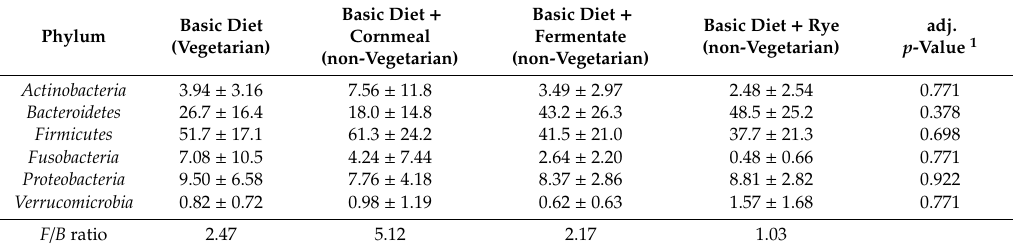
Figure 4. Box-and-whisker plot illustrating the Firmicutes / Bacteroidetes ratio in faecal samples of dogs fed the vegetarian diet (basic diet) or the vegetarian diet supplemented with feather meal as well as either cornmeal (basic diet + cornmeal), fermented rye (basic diet + fermentate) or rye (basic diet + rye). Group means are plotted additionally as rhombus while outliers are plotted individually as points. Table 3. Relative abundance (mean ± s.d., in %) of bacterial phyla > 1% and Firmicutes / Bacteroidetes ratio ( F / B ratio, median) in faecal samples of dogs fed the vegetarian diet (basic diet) or the vegetarian diet supplemented with feather meal as well as either cornmeal (basic diet + cornmeal), fermented rye (basic diet + fermentate) or rye (basic diet +